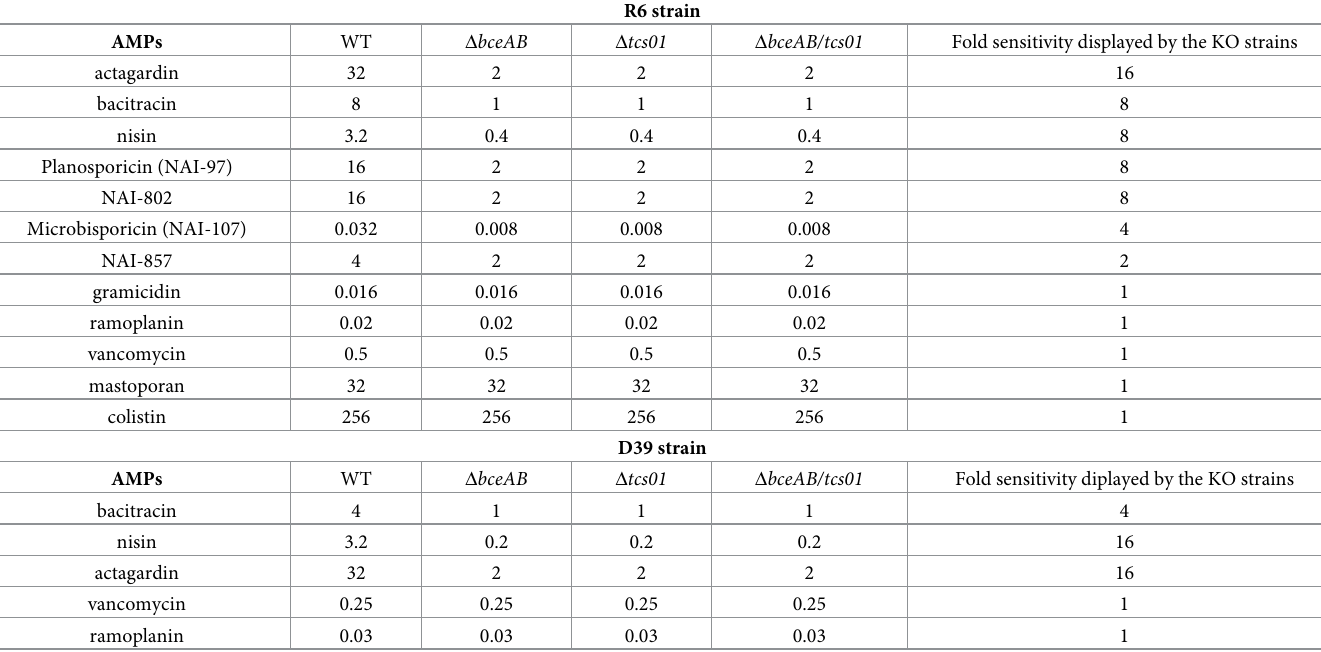
Concentrations (MICs) of a large range of AMPs for the wild-type and mutant strains. The inactivation of the ABC transporter genes notably sensitized the bacterium to a number of antimicrobial peptides, including bacitracin, nisin, actagardin and planosporicin, for which the MICs were reduced by 8 to 16-fold in comparison to the wild-type strain (Table 2). Table 2. Minimum Inhibitory Concentrations ( μ g/ml) of various antimicrobial peptides (AMPs) against the R6 and D39 strains. R6 strain AMPs WT Δ bceAB Δ tcs01 Δ bceAB/tcs01 Fold sensitivity displayed by the KO